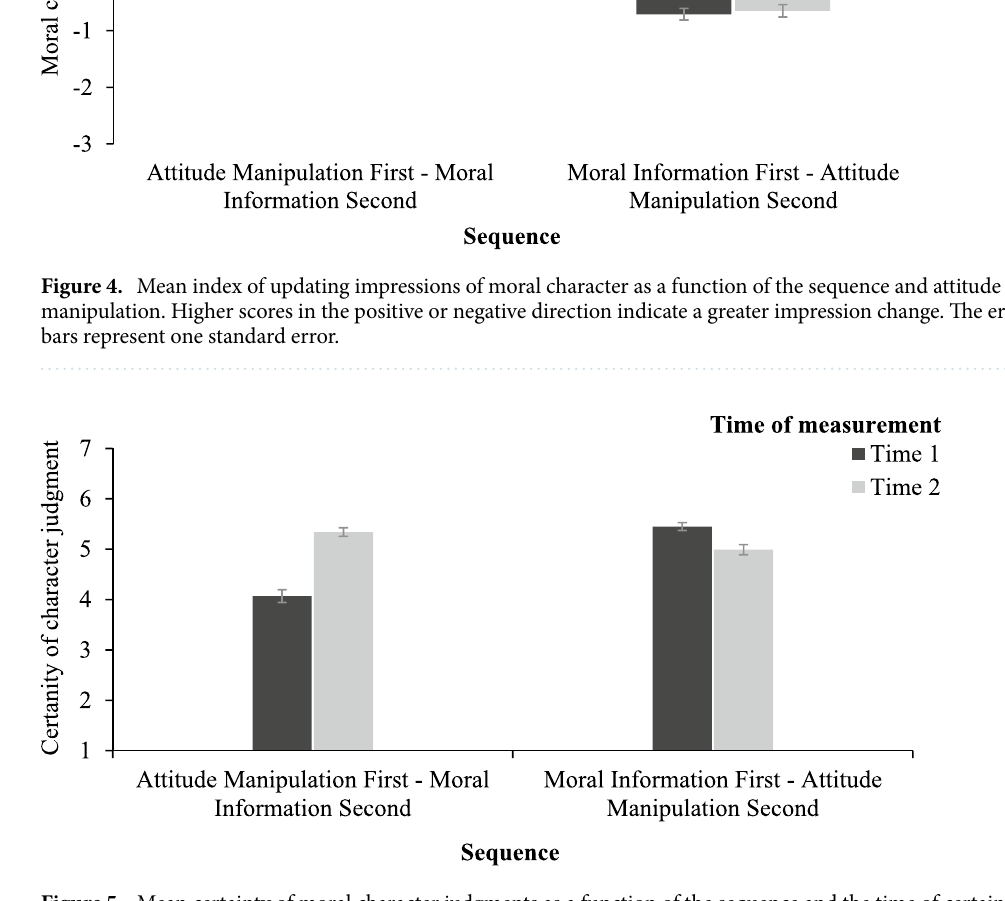
Figure 5. Mean certainty of moral character judgments as a function of the sequence and the time of certainty measurement. Higher scores indicate greater certainty. The error bars represent one standard